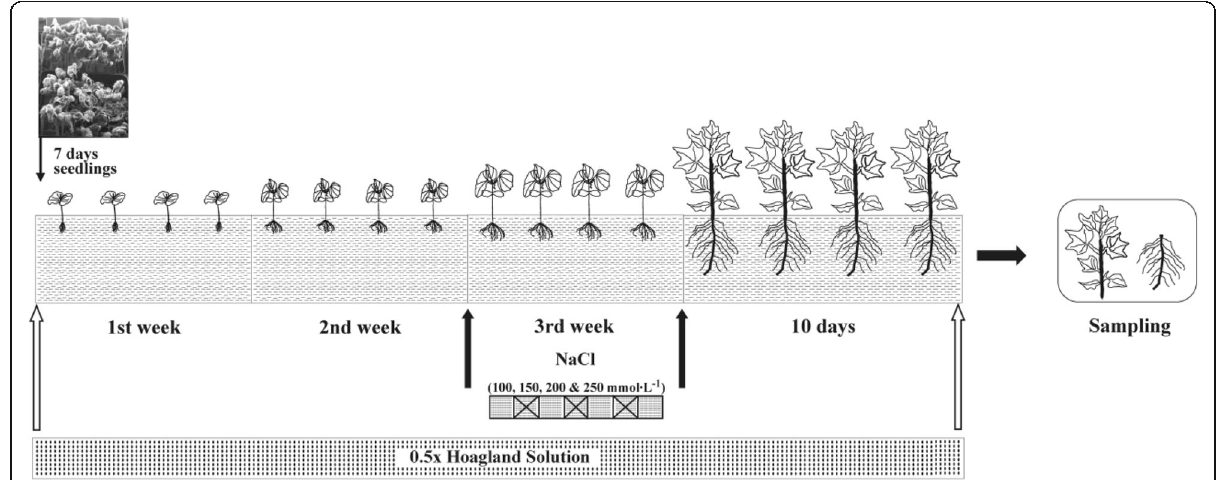
Fig. 1 Schematic representation of the experimental